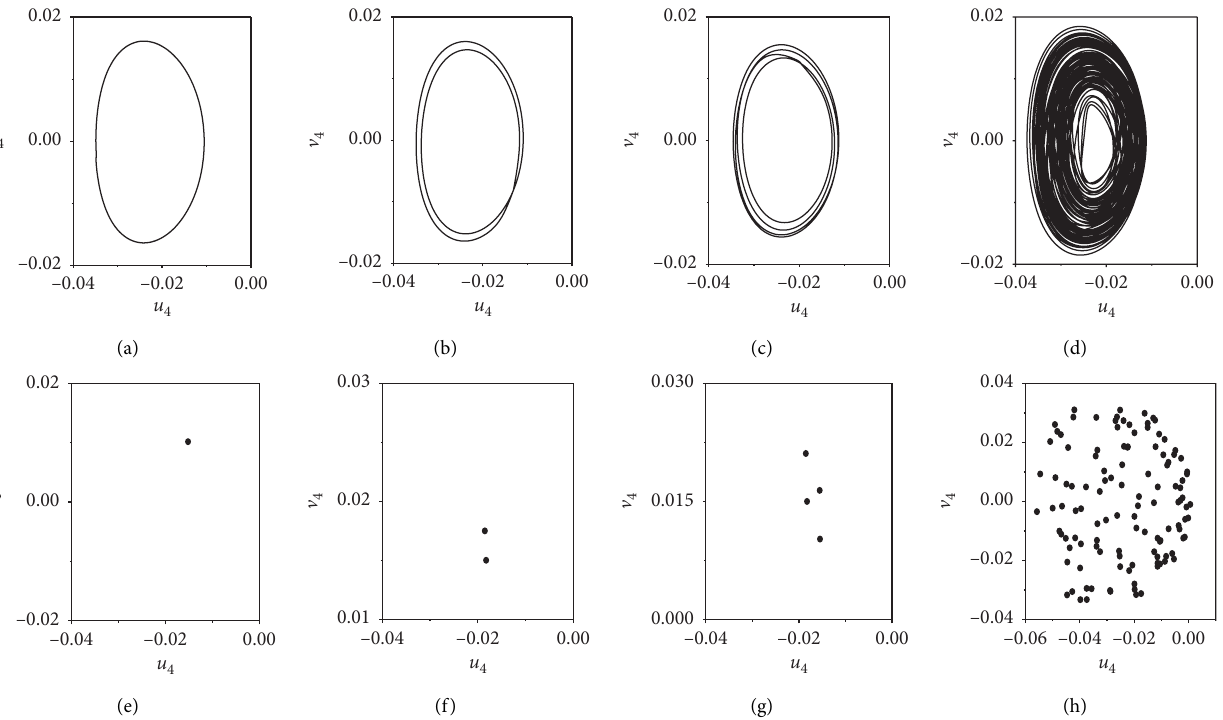
Figure 11: Phase portraits and Poincare maps of the dynamic solutions onto the u � 0 . 05634 (4P); (d, h) σ (2P); (c, g) σ 2